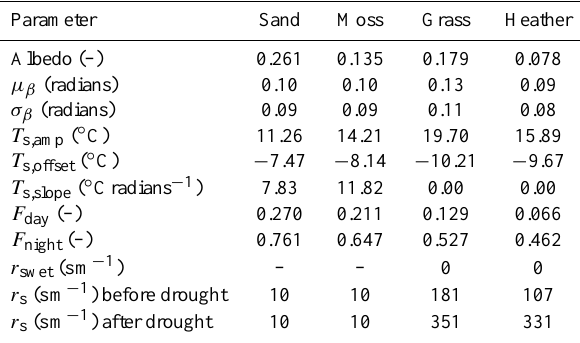
Table 5. Parameters of the four different surfaces used for the cal- culation of ET p for hourly time